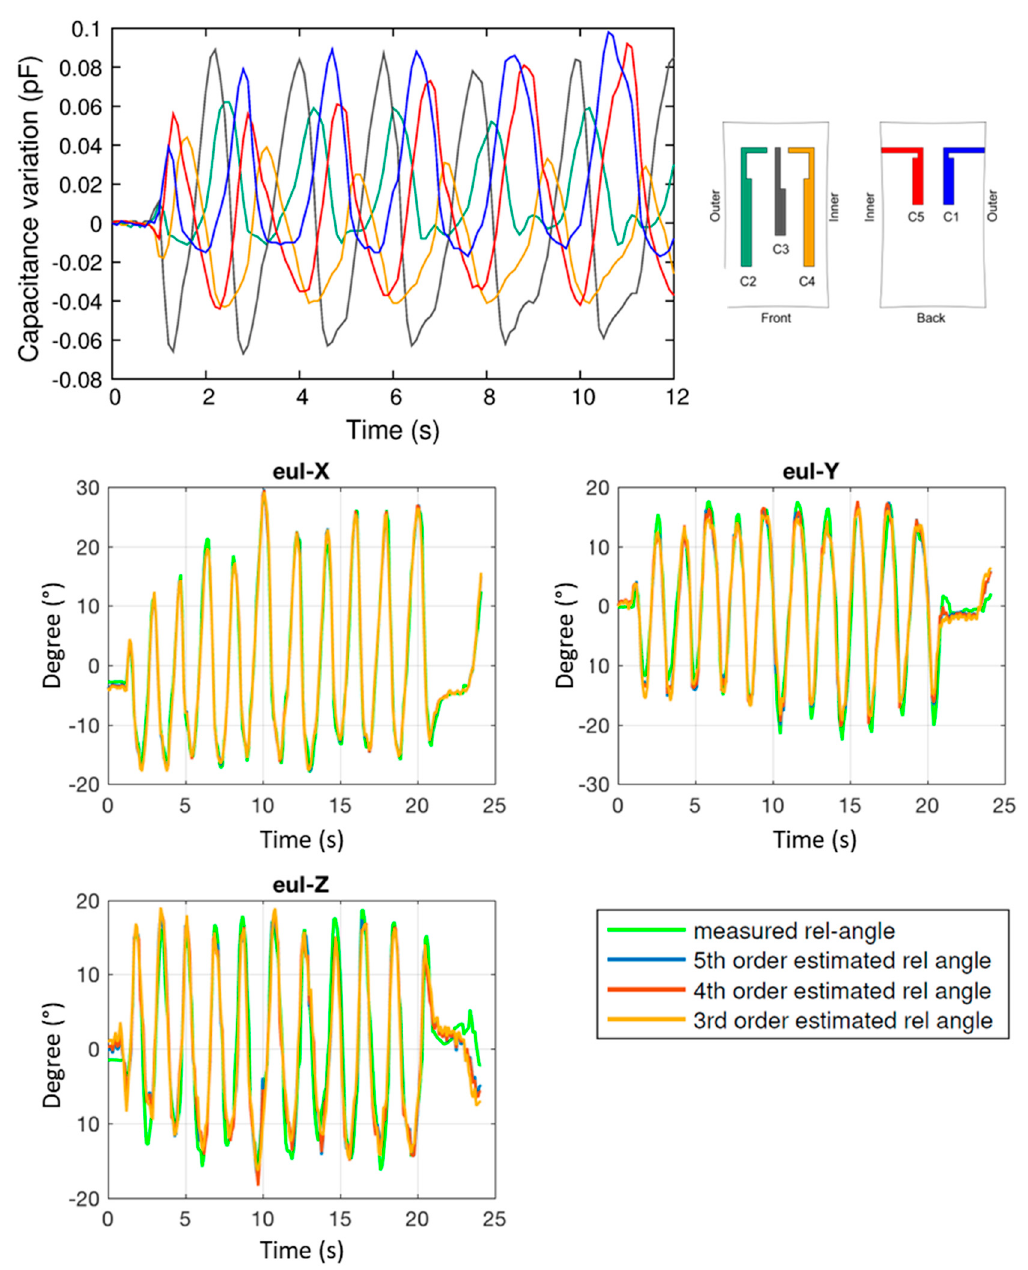
Figure 11. Results of the experimental analysis performed with the anklet during a rotation movement. Top panel : raw capacitance variations of sensors C1 to C5. Bottom panels : reconstruction of the Euler angles (Eul-X, Eul-Y, Eul-Z), and comparison with the values (in green) measured by the optical tracking system.